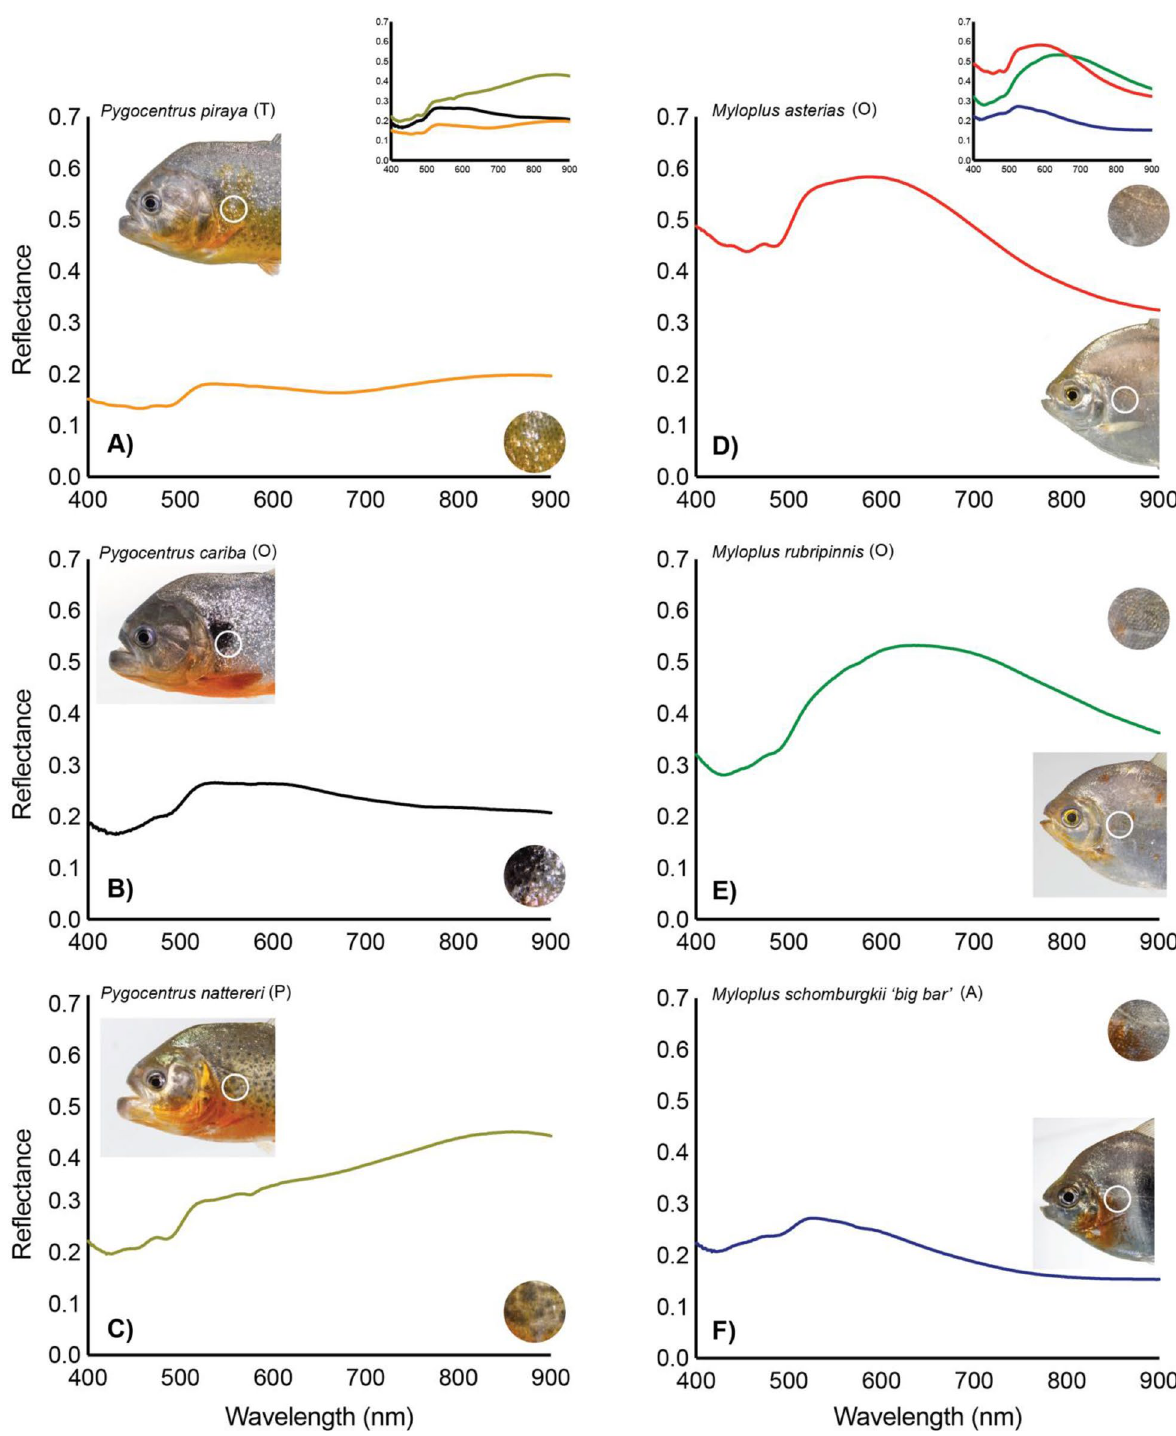
Figure 4. Comparative spectral signatures from three piranha ( a – c ) and three pacu ( d – f ) species. The circular cut-outs illustrate a close-up view of the portion of the fish contributing to each measurement. Differences among species’ spectral signatures can either be changes to the shape of the curve (wavelength) or shifts in the amplitude